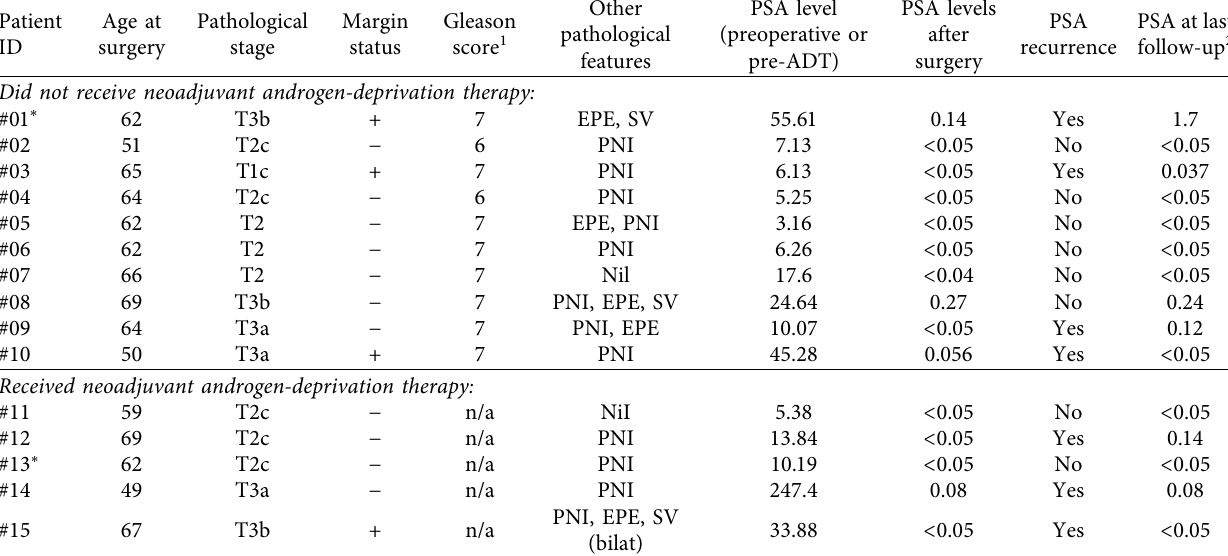
Table 1: Clinicopathological